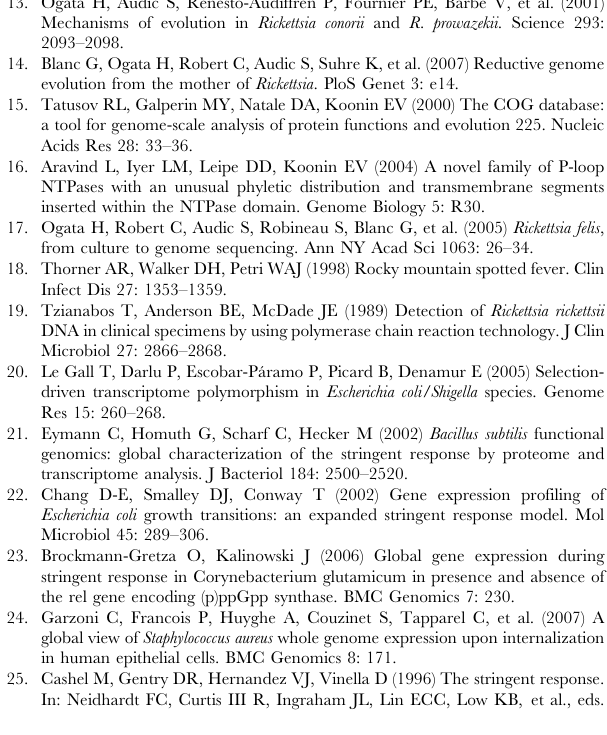
Table S1 List of primers and conditions for qRT-PCR assays